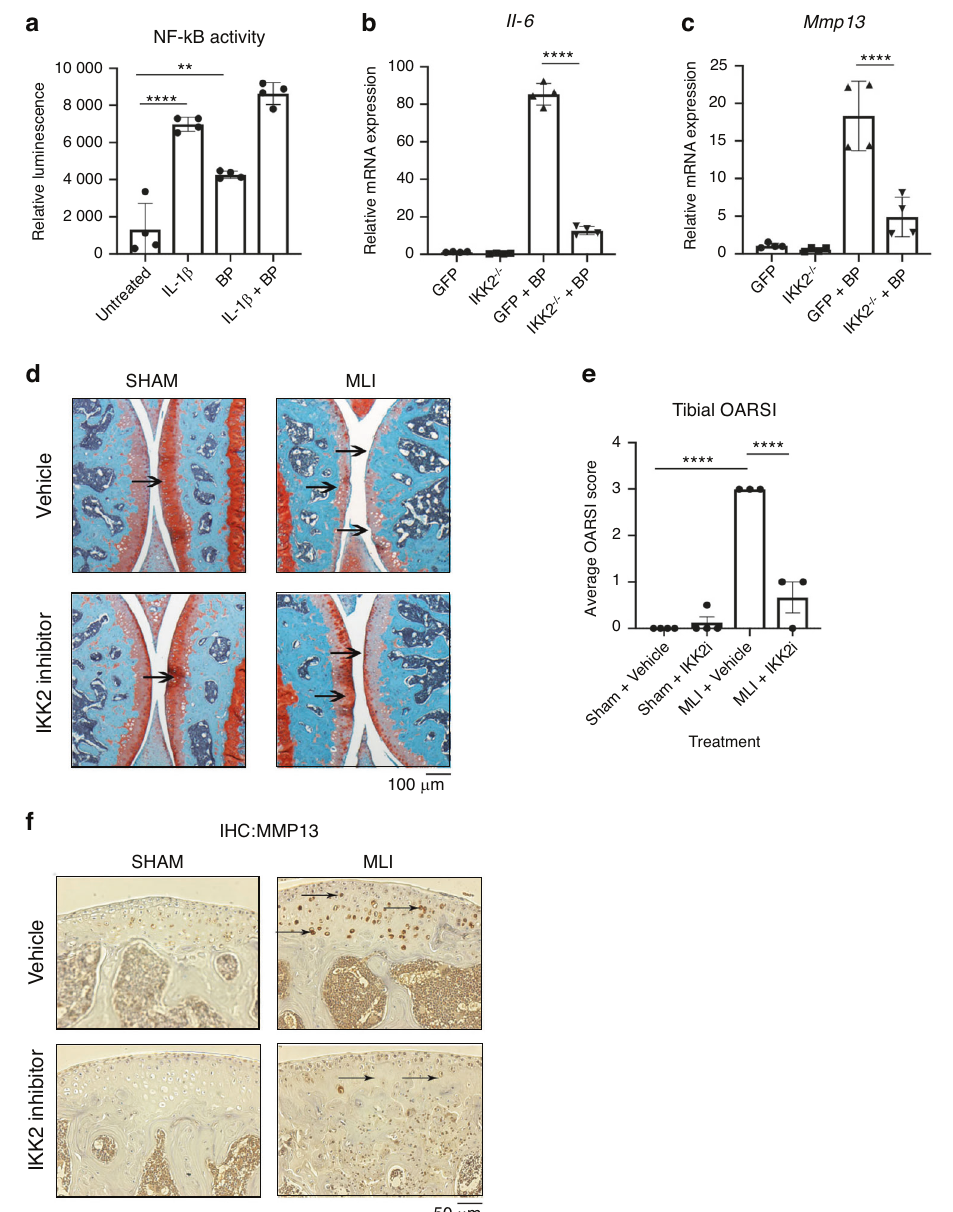
Fig. 3 Bone particles drive the production of catabolic genes via NF- κ B. a Chondrocytes from NF- κ B luciferase reporter mice were cultured with BP or IL-1 β for 24 h. Luciferase assay was performed to measure NF- κ B activation (Untreated vs IL-1 β **** P < 0.000 1, Untreated vs BP ** P = 0.001, n = 4 independent replicates). Results are mean ± SD from one of three representative experiments. b , c IKK2 − / − chondrocytes were transduced with adeno-GFP or adeno-cre. Cells were then cultured with BP for 24 h. Il-6 and Mmp13 gene expression was measured ( IL-6 : GFP + BP vs IKK2 − / − + BP * *** P < 0.000 1. MMP13 : GFP + BP vs IKK2 − / − + BP **** P < 0.000 1). Results are mean ± SD for n = 4 replicates. d MLI surgery was performed on 12-week-old mice. IKK2 inhibitor was injected I.P. for 6 weeks and joints were harvested for histology to perform safranin-O staining, with most damage to tibial surface (arrows). Representative images are displayed. e Blinded OARSI scoring was performed to grade OA severity on the tibial surface (Sham + Vehicle vs MLI + Vehicle **** P < 0.000 1, MLI + Vehicle vs MLI + IKK2i **** P < 0.000 1). Bars represent mean ± SEM. from n = 4 vehicle treated and n = 3 inhibitor treated mice. f IHC was performed for Mmp13 in articular cartilage of joint sections under the same conditions. Representative images are